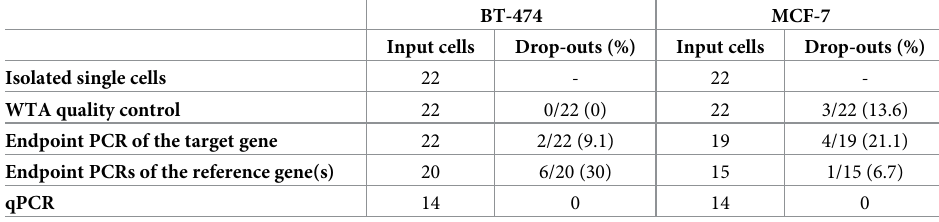
Table 1. Stepwise drop-out rates during sample selection for